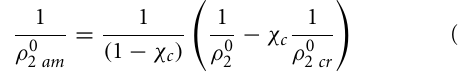
Table 1 | Thermophysical properties of the investigated PEEK samples. Polymer T g (from DSC) a ( ◦ C)